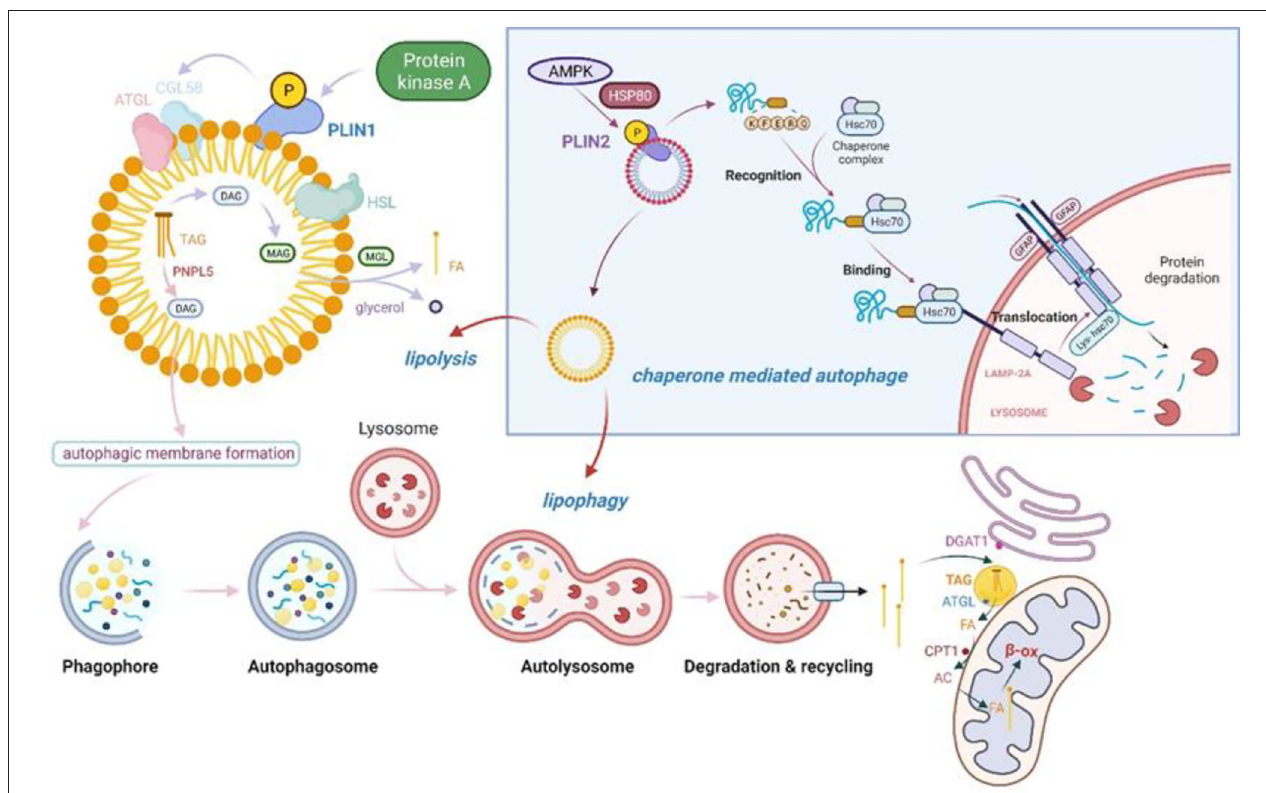
FIGURE 4 | Lipolysis and lipophagy in tandem with molecular chaperone-mediated autophagy (CMA). PKA phosphorylates PLIN1, a member of the PAT protein family, and causes its degradation. This induces the release of CGI-58, which then initiates TAG catabolism via activated ATGL. ATGL catalyzes the first step of TAG hydrolysis, producing DAG and free fatty acids. The second step of lipolysis is dependent on the activation of HSL, the rate-limiting enzyme in the lipolysis cascade reaction (113). HSL hydrolyses DAG to produce monoacylglycerols and FFAs, which are excreted from LDs and enter the mitochondria for β -oxidation (113). In addition, the novel neutral lipase PNPLA5 in LDs has triglyceride hydrolase activity and can hydrolyze TAG to DAG, promoting autophagic vesicle membrane formation in a PNPLA5-dependent manner. Furthermore, LDs are also present as a ’staging area’ for the entry of FFAs into mitochondria for β -oxidation, thus protecting them from damage by toxic ACs and excess FFAs ( 114). CMA may be an important link in the initiation of lipophagy and lipolysis. AMPK phosphorylates PLIN2 on LDs in an HSP80-dependent manner, allowing it to be degraded by lysosomes by way of CMA. The degradation of PLIN2 allows lipid droplets to undergo subsequent lipophagy and lipolysis. PKA, protein kinase A; PLIN, perilipin; CGI-58, comparative gene identification-58; TAG, triacylglycerides; ATGL, adipose triglyceride lipase; DAG, diacylglycerol; HSL, hormone-sensitive lipase; FFAs, free fatty acids; LDs, lipid droplets; PNPLA5, Patatin-like phospholipase domain containing 5; DGAT1, diacylglycerol acyltransferase 1; CPT1, carnitine palmitoyltransferase 1; AC, acylcarnitine.